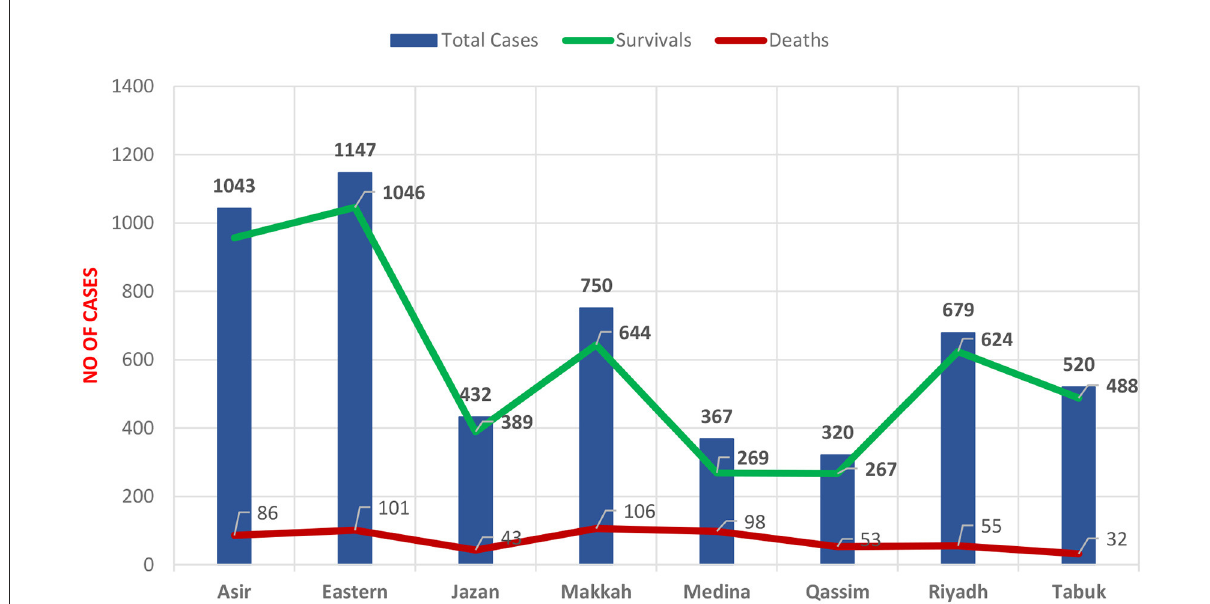
FIGURE1 Distributions rate of hospitalized patients diagnosed with COVID-19 among Saudi regions, Mar 2020-Jan